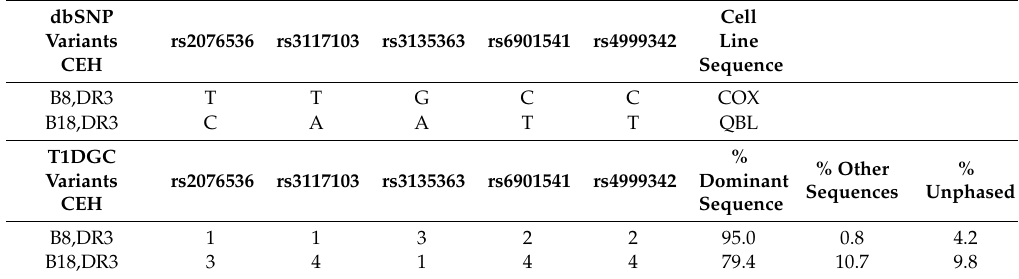
Table 1. T1DGC MHC Fine Mapping SNPs to distinguish B8,DR3 and B18,DR3 CEHs 1